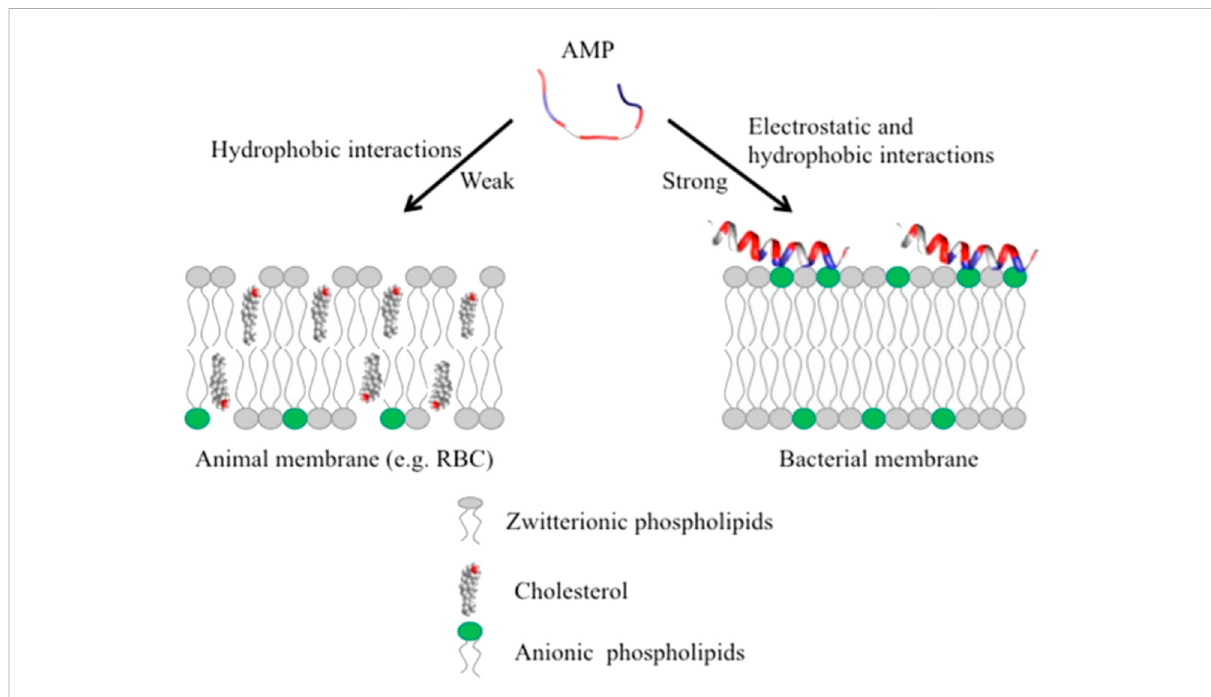
FIGURE 4 Unlike animal membranes, bacterial membranes are composed of negatively charged phospholipid head groups which attract the positive charge of AMPs, adapted from Kumar et al., 2018.